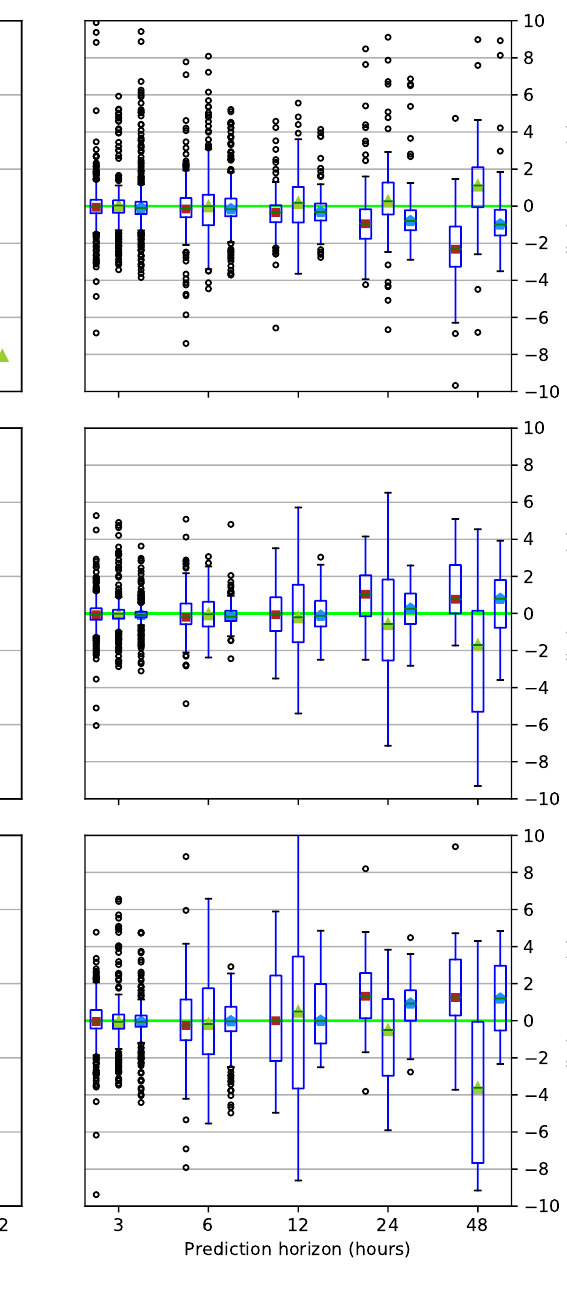
Figure 5. Summary of control KPIs ( left ) and the n-step-ahead prediction errors for each model and experiment ( right